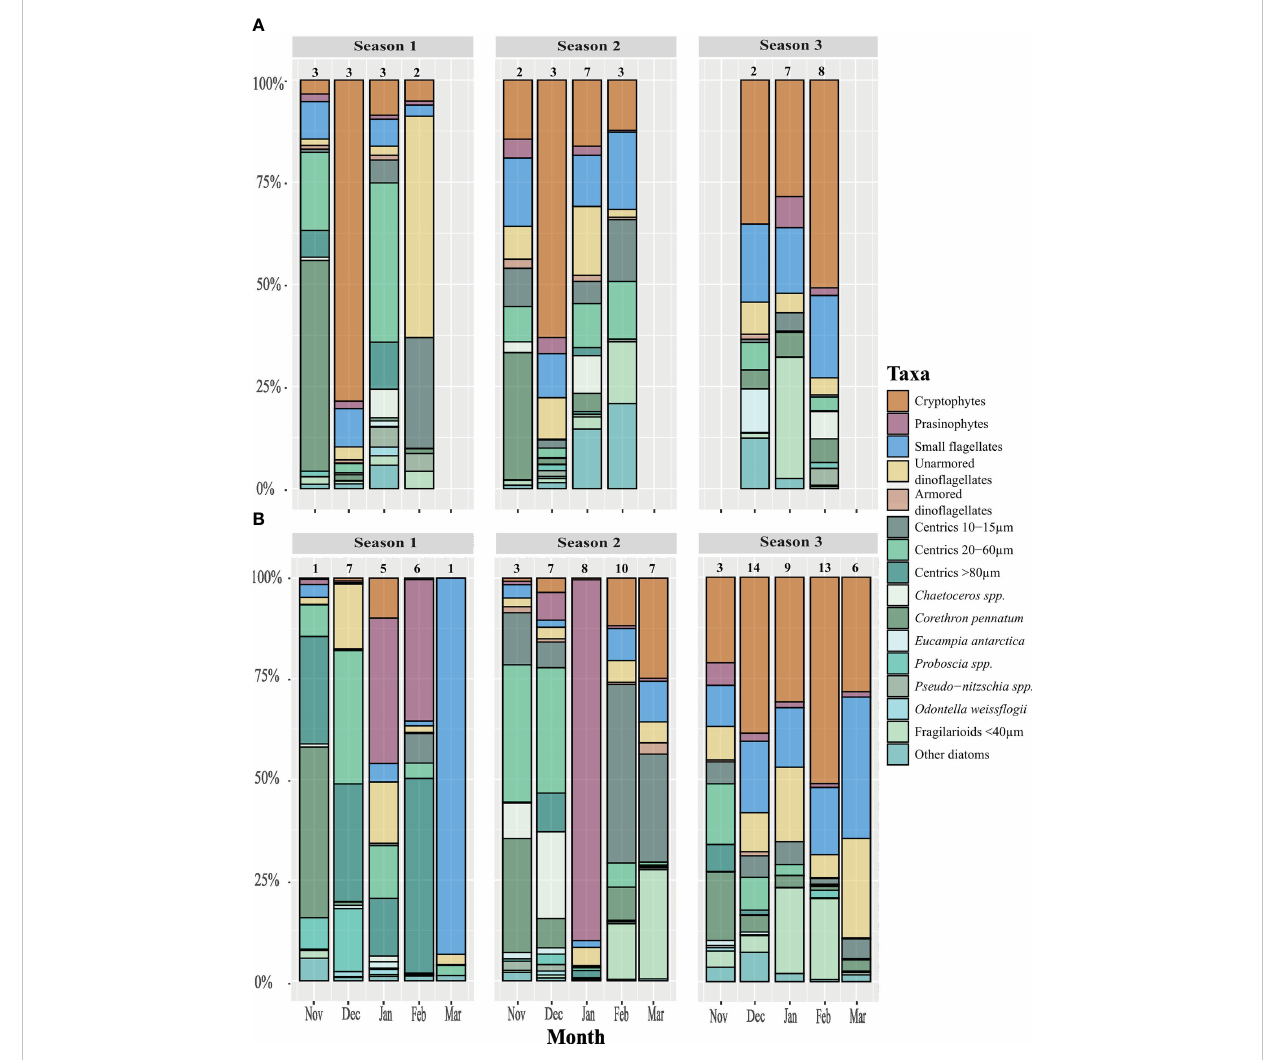
FIGURE 6 Bar plot of relative biomass speci fi c composition of representative taxa in (A) North and (B) South zones of the Gerlache Strait from November to March 2016-2017, 2017-2018, and 2018-2019. This graph was constructed by averaging the samples obtained in each zone during that month and season, the n of the averaged samples can be seen above each bar. Note that this is a percentage graph and that the changes in biomass are relative. All diatoms are colored in shades of